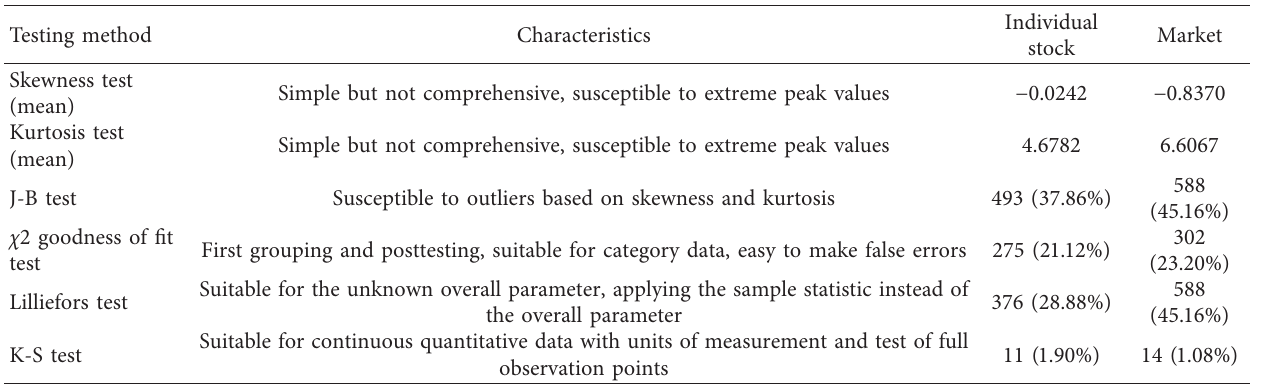
Table 4: Advantages and disadvantages of the normality test method and the events failed.